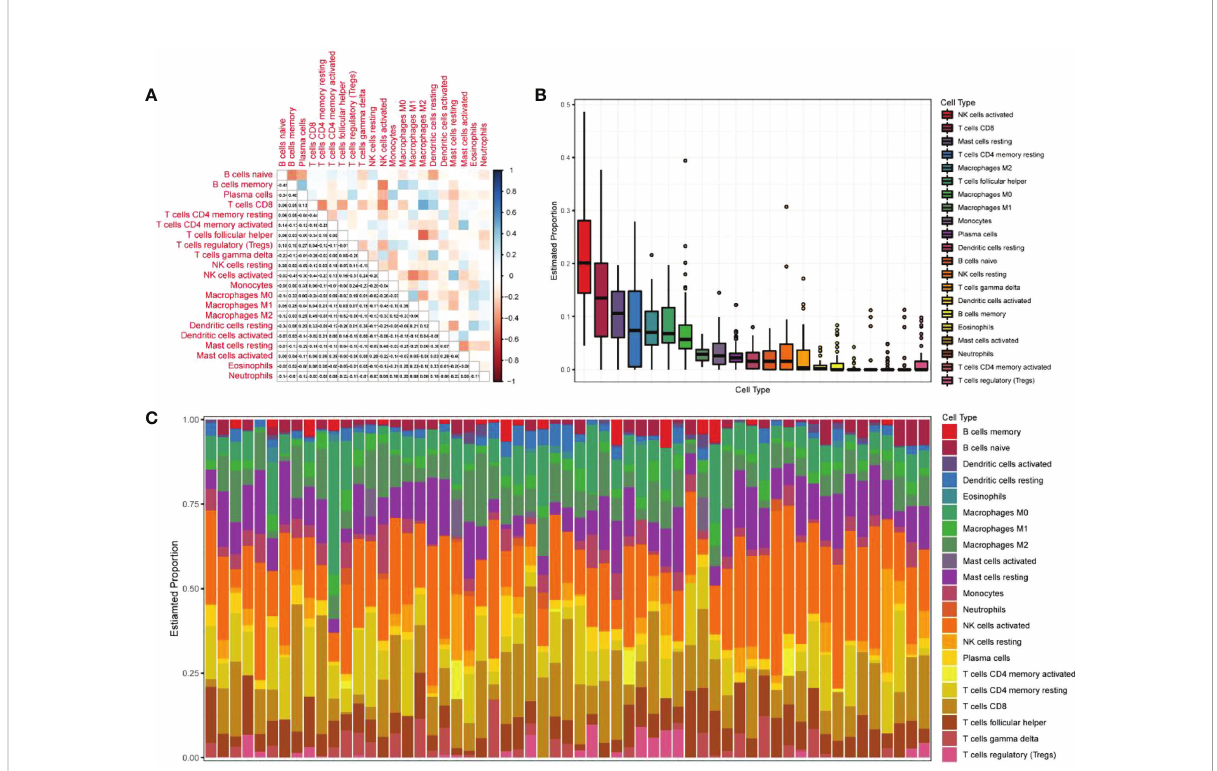
FIGURE 5 Analysis of immune in fi ltration results. (A) Correlation analysis between different kinds of immune cells, red represents positive correlation, blue represents negative correlation, the darker the color, the higher the correlation; (B) the proportion of different immune cells in all samples; (C) The proportion of different immune cells in a single